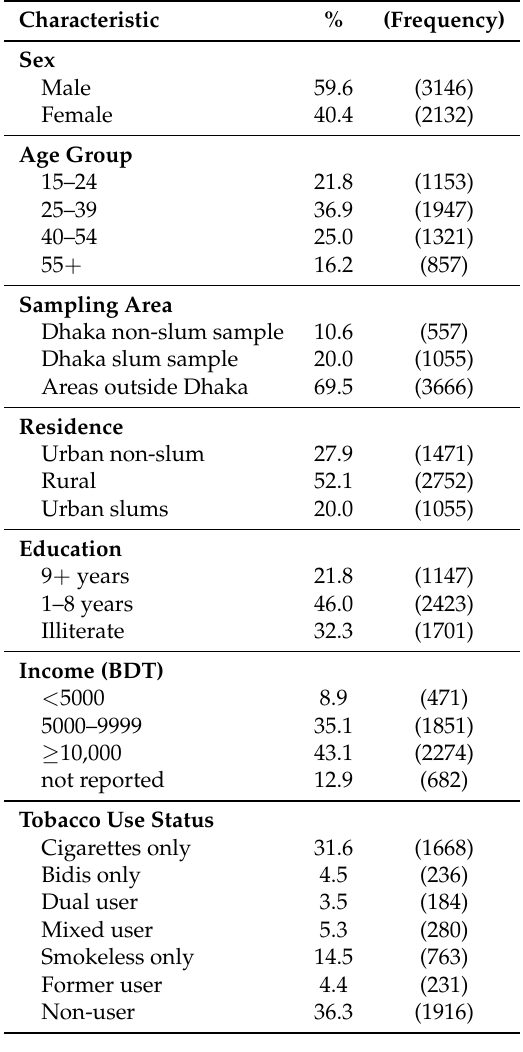
Table 1. Demographic characteristics of the respondents participating in Wave 3 of the ITC Bangladesh survey (unweighted